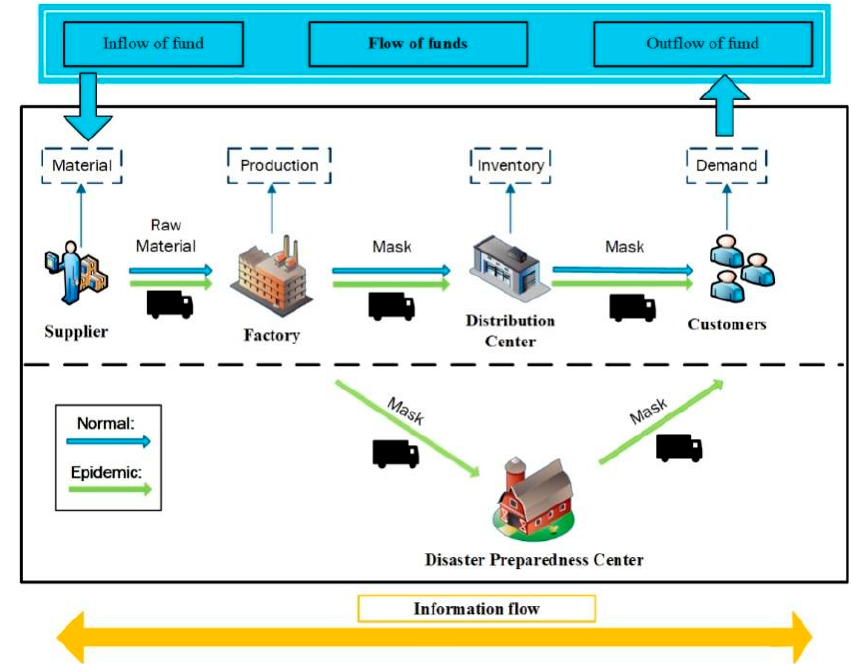
Figure 3. Material and information flows in supply chain.